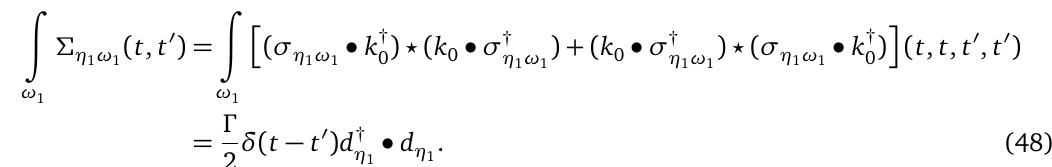
Figure 12: Energy-integrated functional Σ integration, the two-branch convolution reduces to a δ -function in